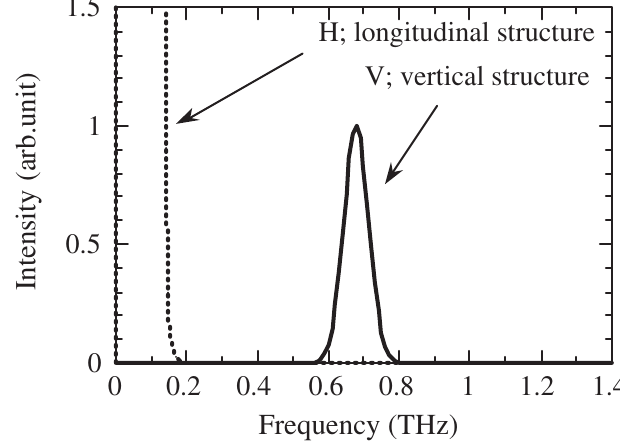
FIG. 3. Power spectrum of CSR at n ¼ 22 ( t ¼ 22 (cid:1)=! S ) and ¼ 0 . The ‘‘H’’ and ‘‘V’’ indicate the direction of the polar- (cid:7) 0 ization. The vertical axis is normalized with the peak for the vertically polarized CSR produced by the vertical structure.